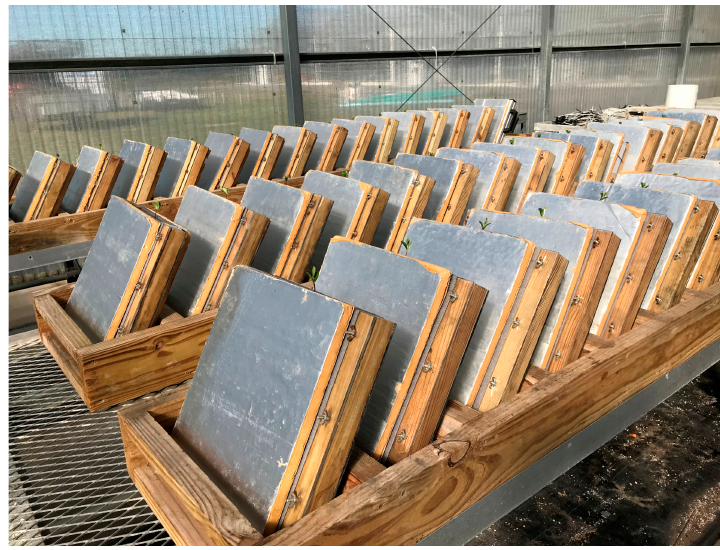
Figure 5. Soybean seedlings grown in rhizotrons.